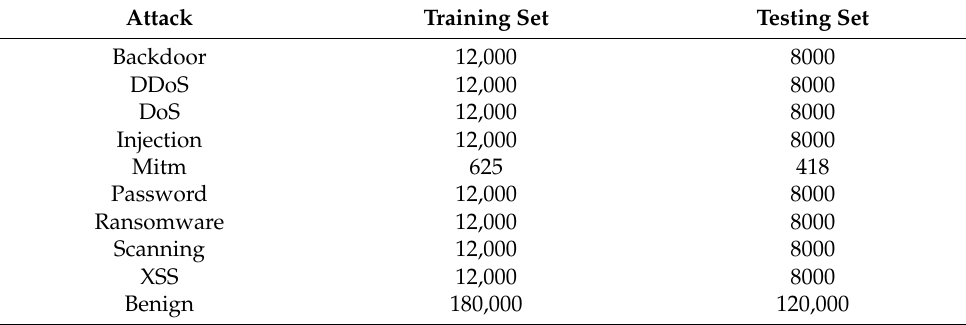
Table 4. Training set and testing set used in [46].